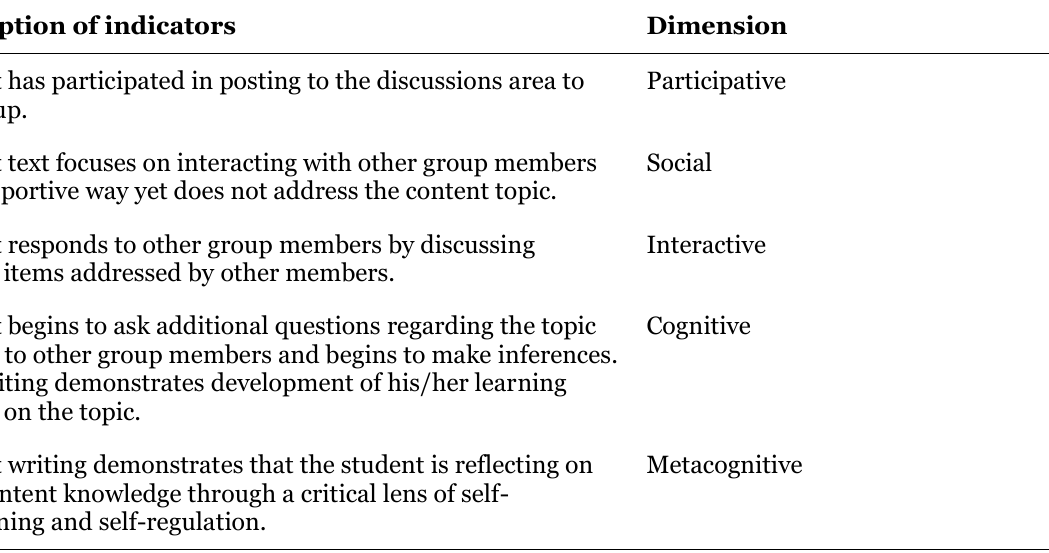
Summary of Henri’s (1992) Five Dimensions of Content Analyses Description of